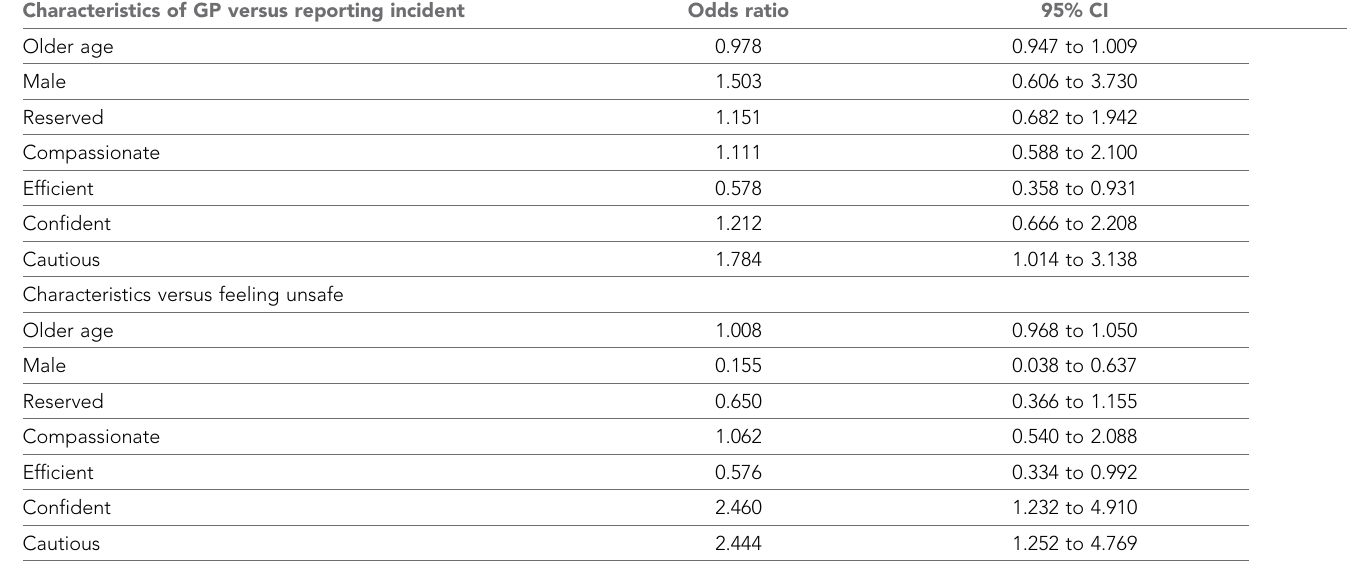
Table 6. Relationship between GPs’ characteristics and reporting an aggressive incident, and relationship between GPs’ characteristics and